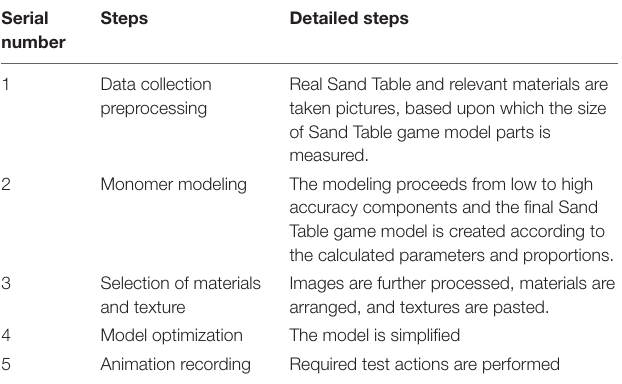
TABLE 3 | Three-dimensional (3D) reconstruction of Sand Table game